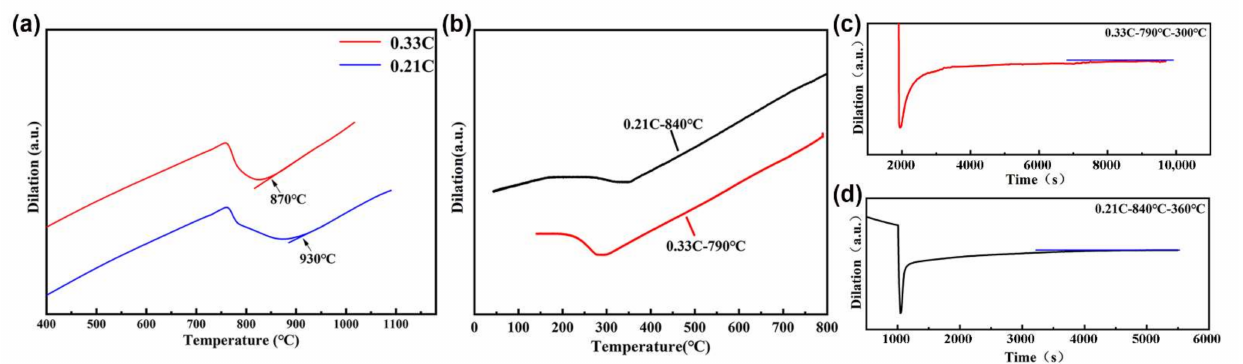
Figure 1. Schematic illustrations of the thermomechanical processes of the ( a ) 0.33C and ( b ) 0.21C steels.